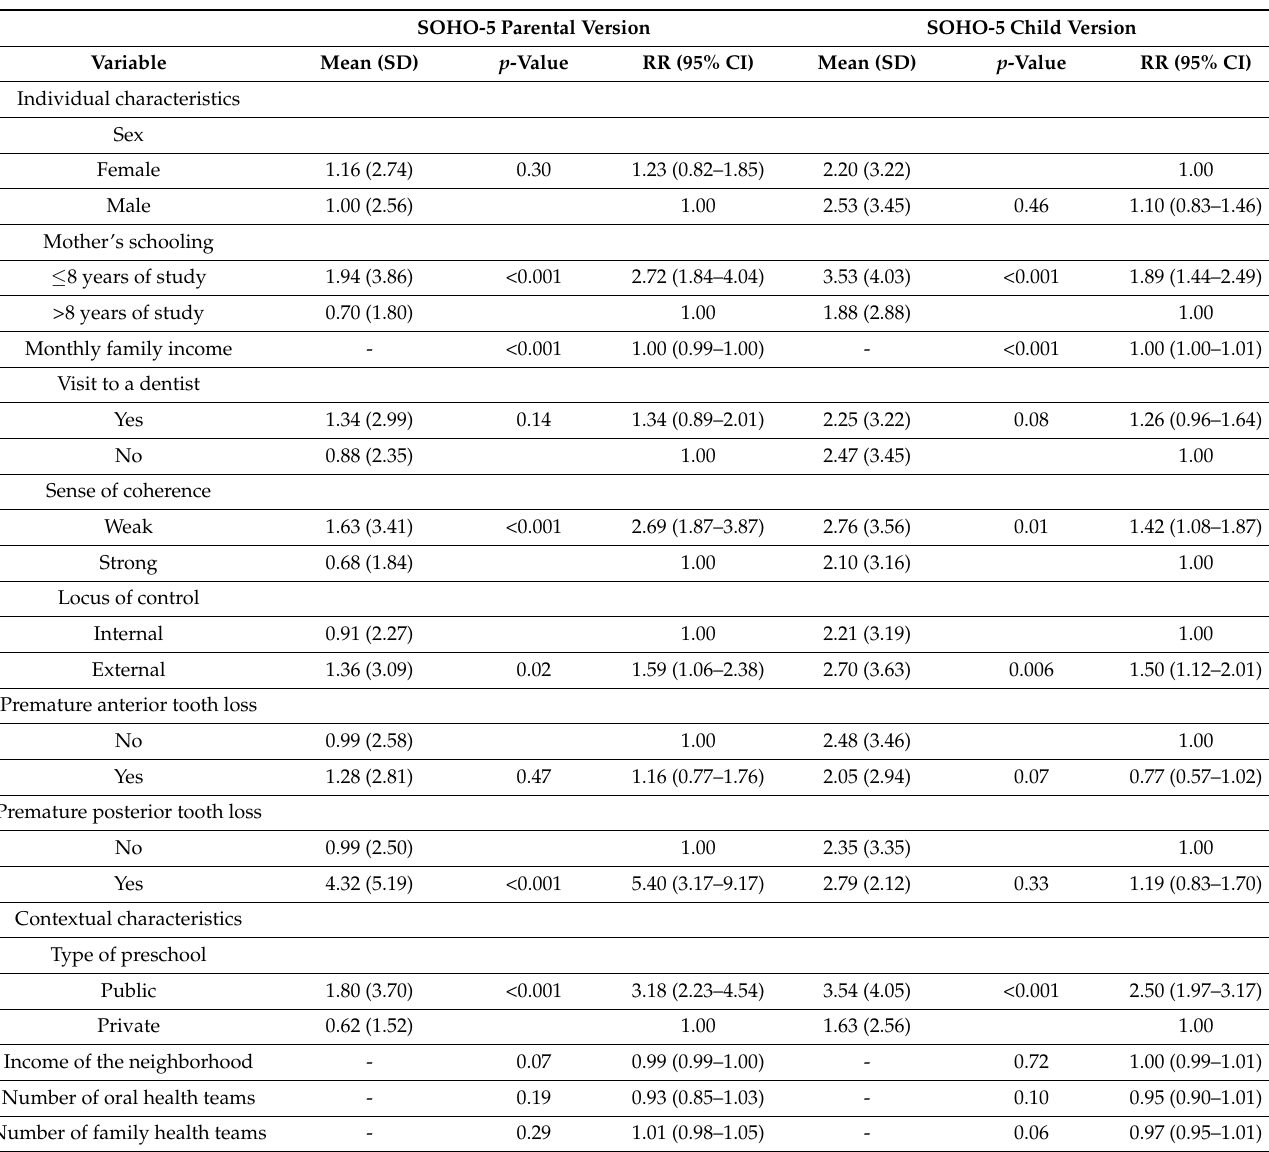
Table 2. Bivariate analysis of the association between the general SOHO-5 scores and individual and contextual